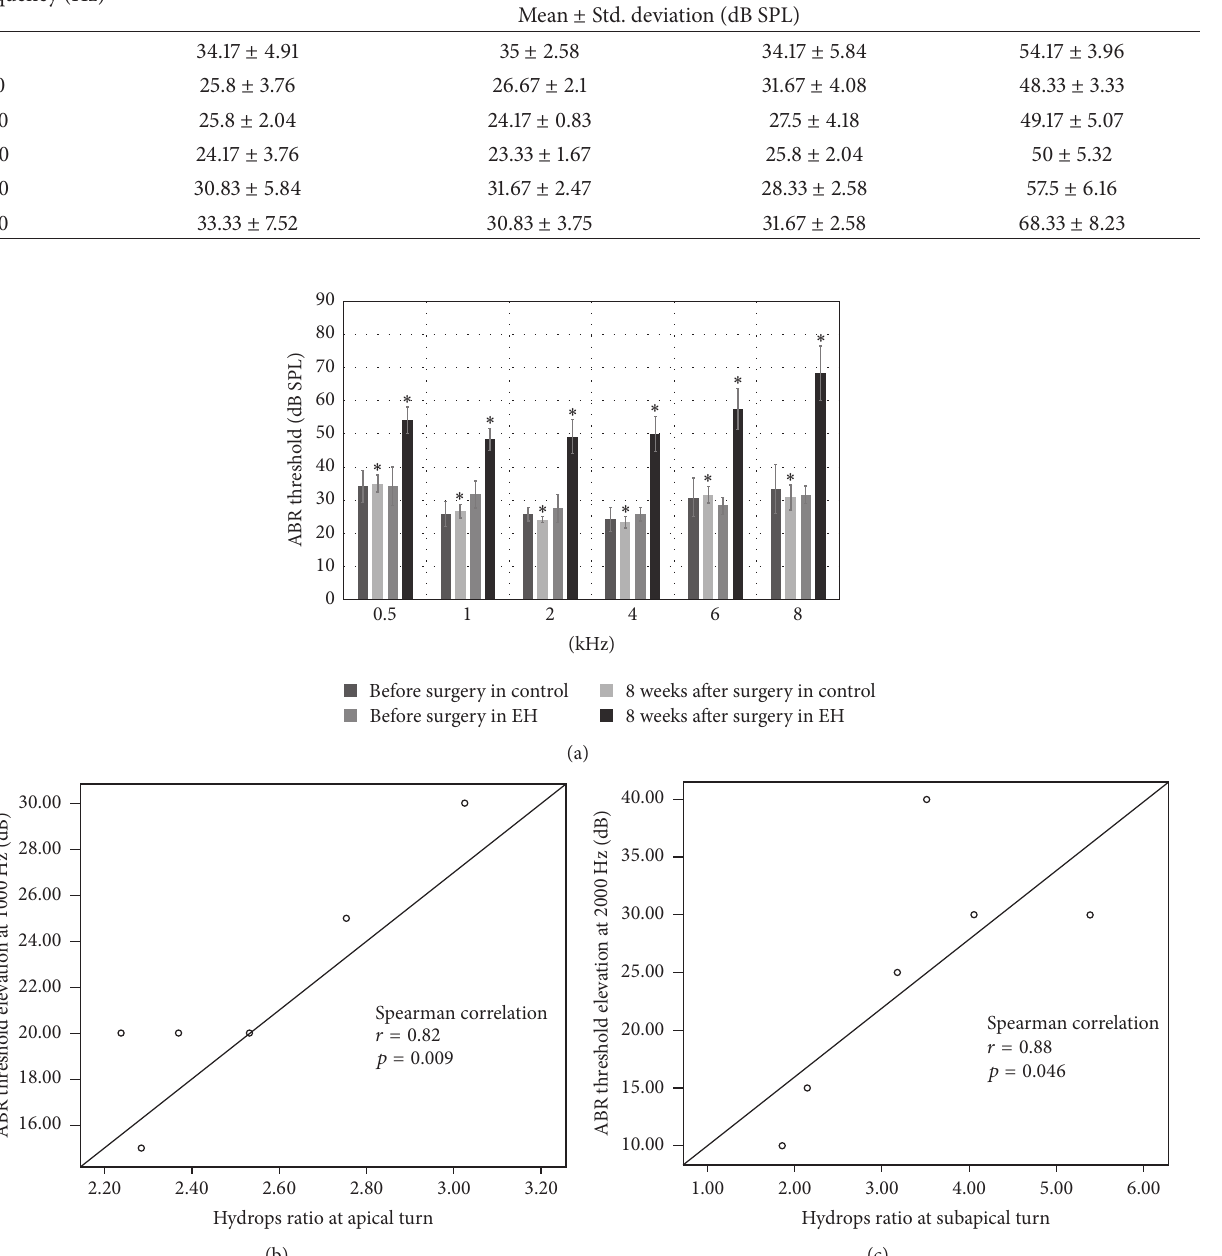
Table 2: The ABR threshold of the control group and EH group at the frequency of 0.5, 1, 2, 4, 6, and 8 kHz. Frequency (Hz)